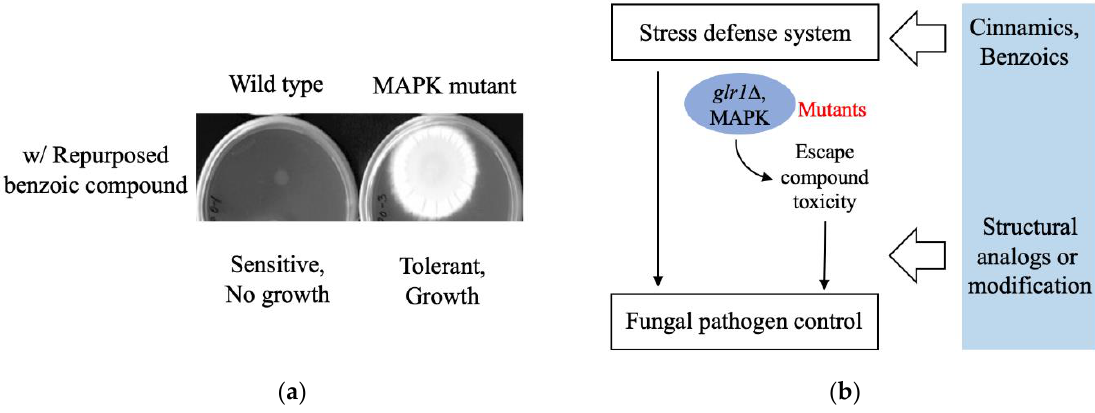
Figure 2. ( a ) A. fumigatus MAPK mutant showing tolerance to the repurposed benzoic ingredient (Kim et al., unpublished observation); ( b ) scheme describing structural modifications of cinnamates or benzoates that could overcome the tolerance of S. cerevisiae glr1 ∆ or A. fumigatus MAPK mutants, respectively, to the repurposed compounds (see Figure 1 and [243] for